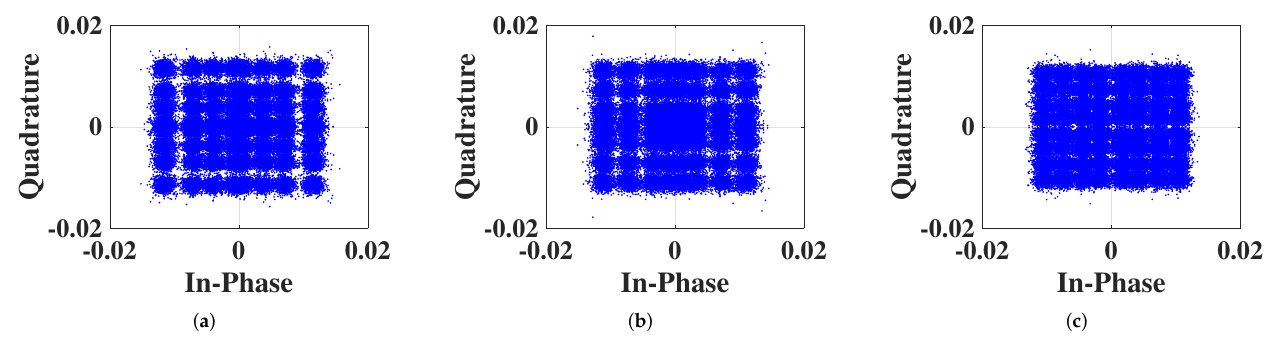
Figure 12. The SCs of the three-user NOMA VLC system obtained by experiment, when γ 1 = 18 dB. ( a ) No adjustment scheme; ( b ) SC-A scheme; ( c ) SC-SIC-A